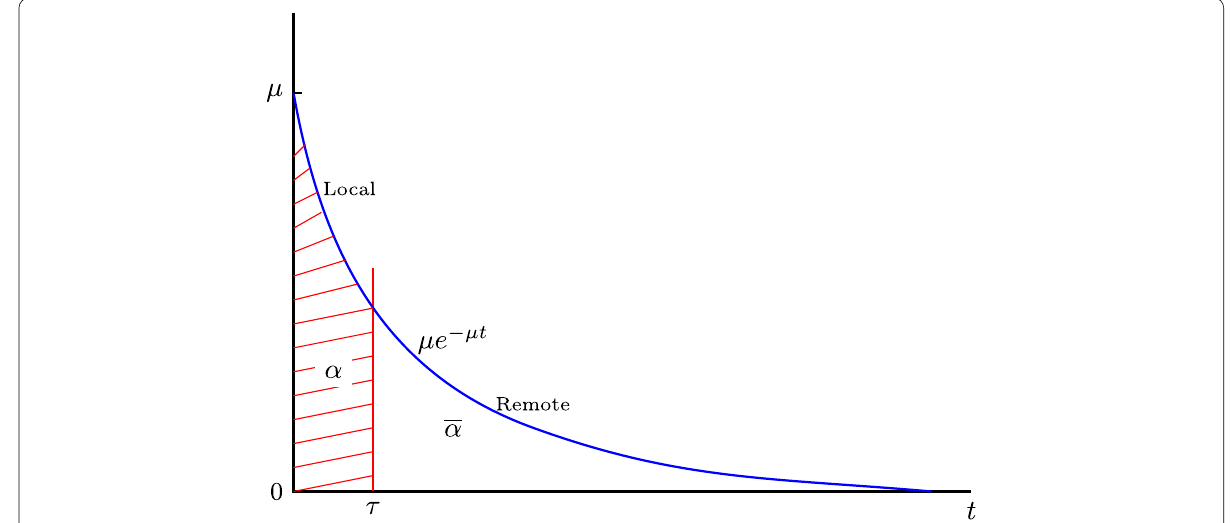
Fig. 3 The offloading threshold, τ , partitions the exponential curve into two truncated exponentials. Under the curve, the shaded area represents the fraction α of tasks that are local, while the complementary white area represents the fraction α of tasks that are